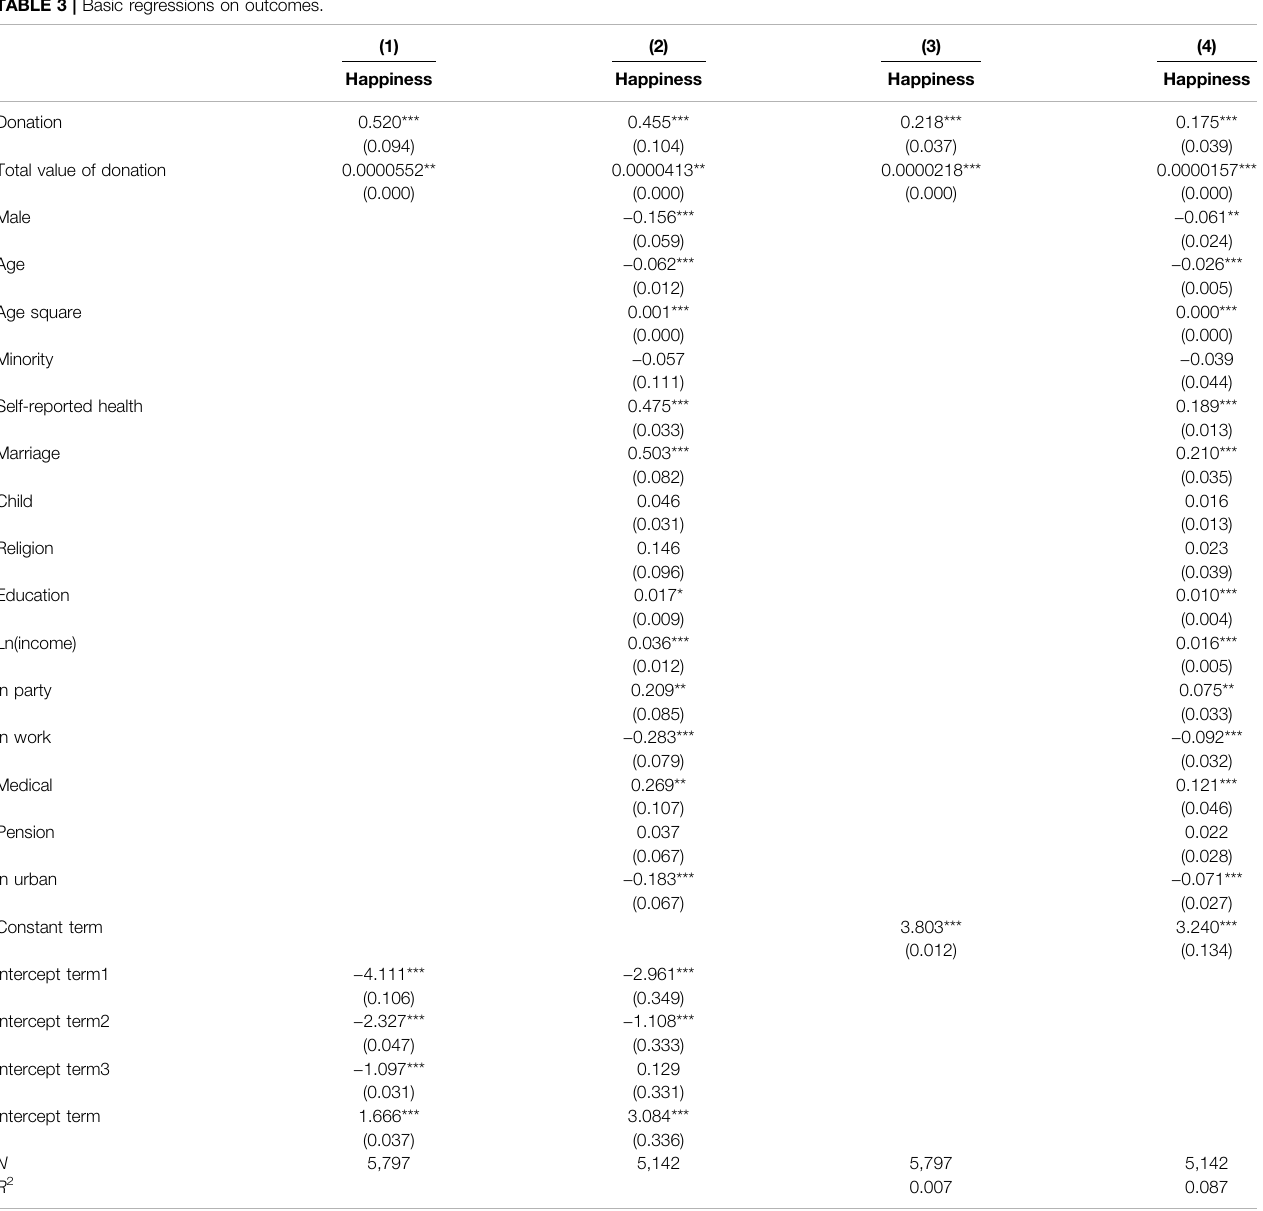
TABLE 3 | Basic regressions on